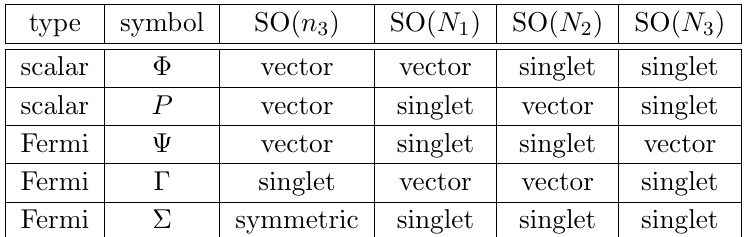
Table 1 . The (cid:12)eld content of our 2d (0 ; 1) SQCD with gauge group SO( n 3 ).